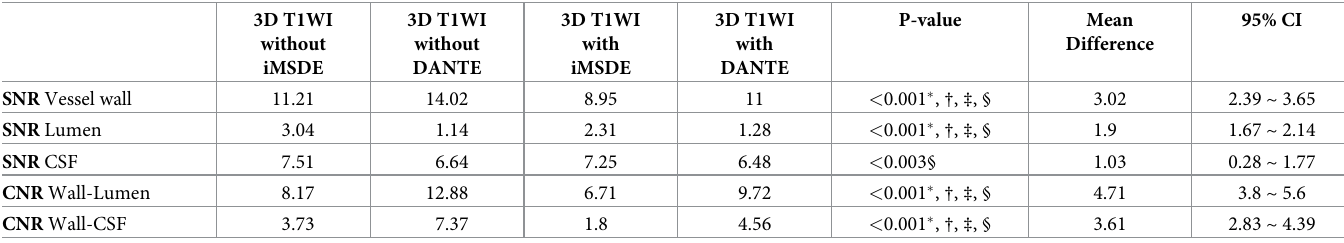
Table 2. Comparisons of SNR and CNR between 3D TSE T1WI with or without iMSDE and DANTE.